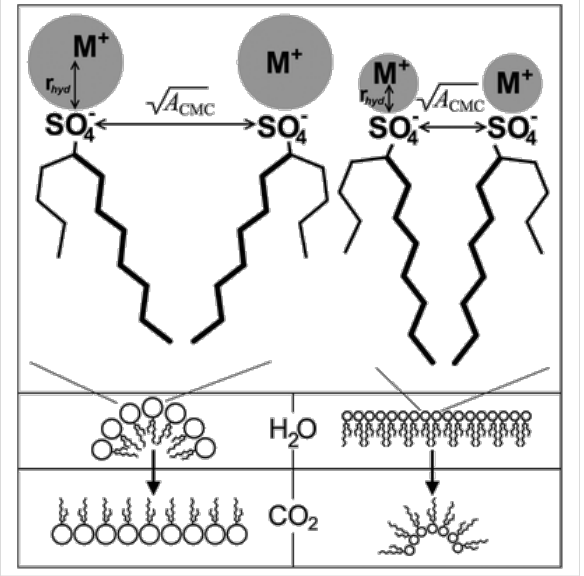
Figure 6: Schematic showing how hydrated cation radius ( r hyd ) medi- ates surfactant headgroup repulsions by controlling limiting headgroup area at critical micelle concentration ( A cmc ). Changes in A cmc and r hyd affect preferred curvature and therefore aggregate morphology in water and scCO 2 . Reprinted with permission from [32]. Copyright 2012 American Chemical Society.